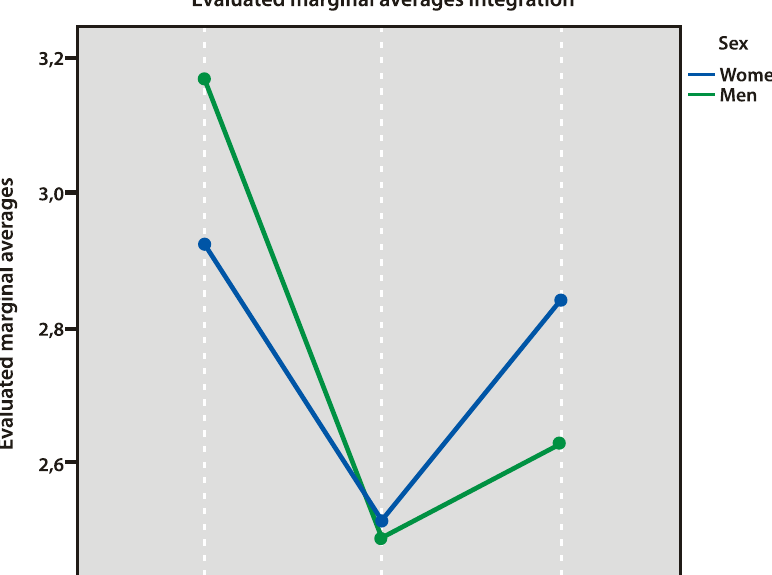
Figure 7. Strategy of marginalization.